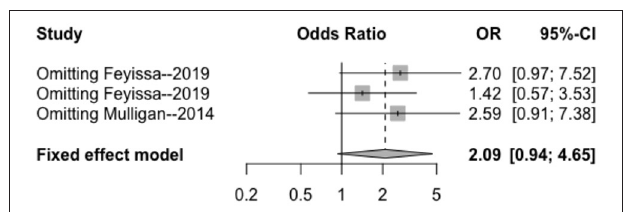
FIGURE 9 | Sensitivity analysis of the correlation between 1p/19q deletion and perioperative epilepsy. CI, confidence interval; OR, odds ratio.